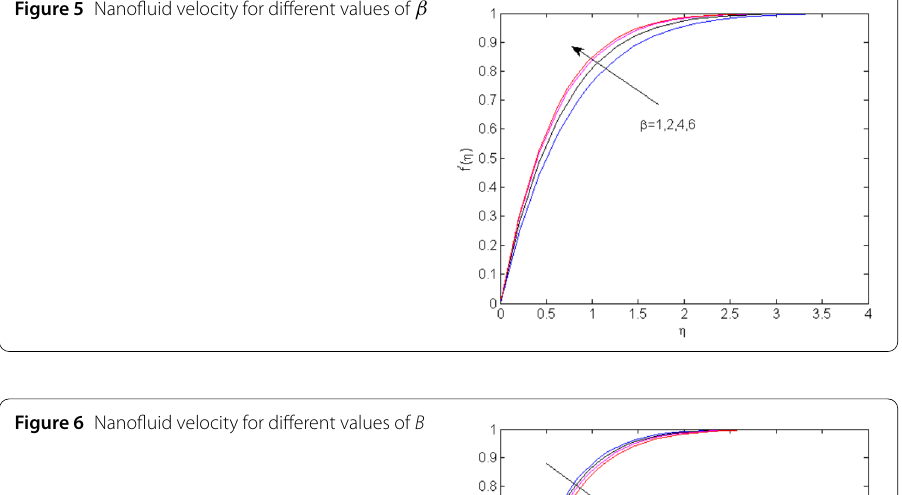
Figure 6 Nanofluid velocity for different values of B